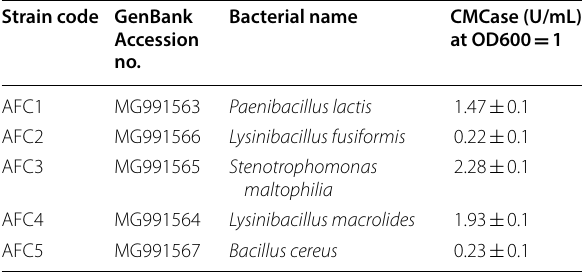
Table 3 Molecular identification of the five bacterial strains according to 16S rDNA gene sequence and their cellulase activity (U/mL) Strain code GenBank